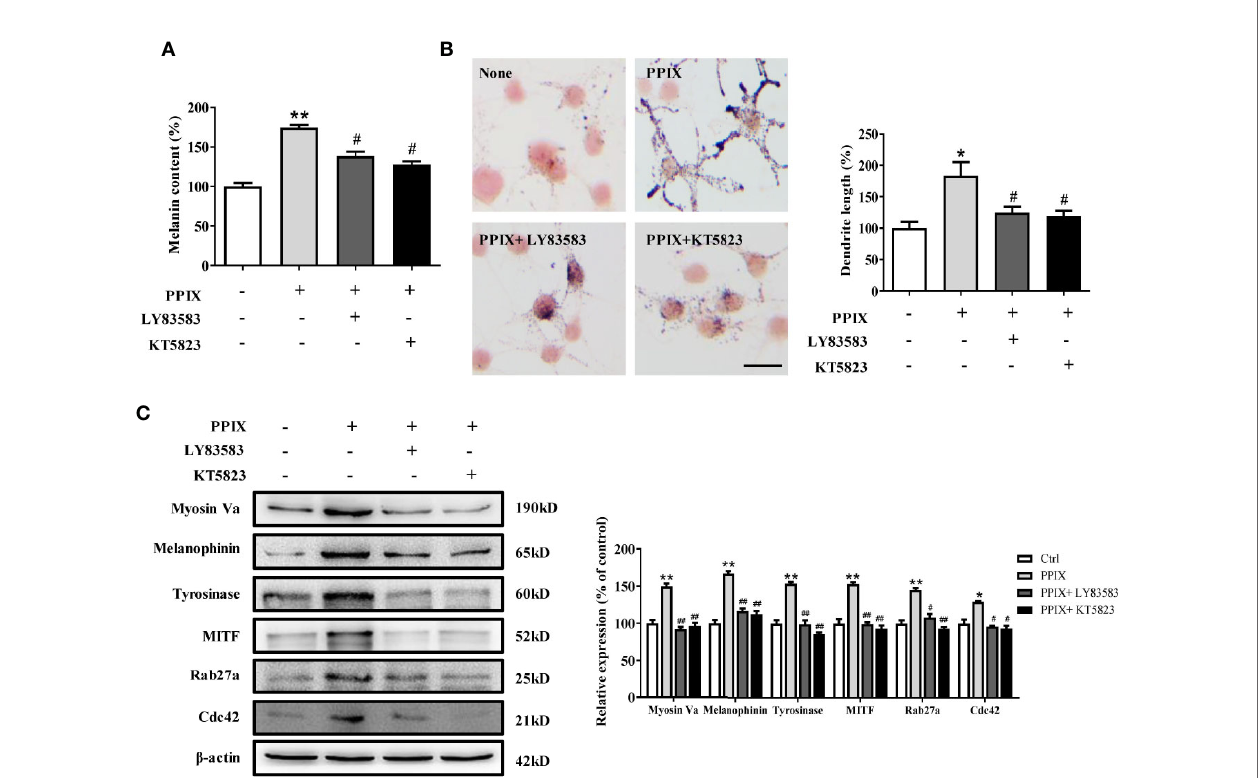
FIGURE 5 | Inhibitory effects of LY83583 and KT5823 on PPIX-induced pigmentation in SK-MEL-2 cells. SK-MEL-2 was pretreated or not with 10 m M LY83583 (or 1 m M KT5823) for 1 h before PPIX was applied for 48 h at 30 m M. (A) Melanin contents were measured, and (B) SK-MEL-2 cells were stained with Masson-Fontana ammoniacal silver stain. Bar = 20 m m. Total length of dendrites per cell was measured on the pictures using ruler. (C) Western blotting for the protein expression relating to melanogenesis and melanosome transport were measured. Data are expressed as the mean ± SEM (n = 3). *p < 0.05, **p < 0.01 versus non-treated cells. # p < 0.05, ## p < 0.01 versus PPIX-treated